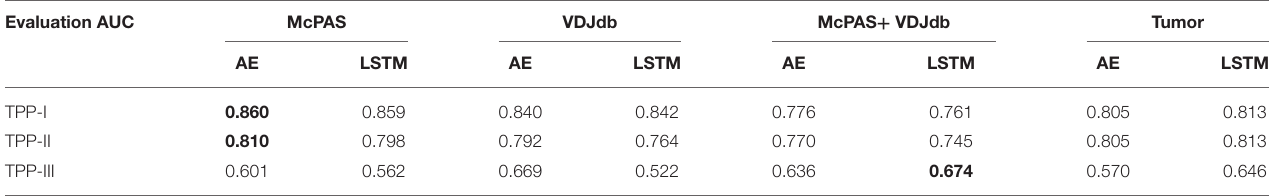
TABLE 4 | AUC of TPP task with either known peptide and TCR (but unknown pairing TPP-I), known peptide unseen TCR (TPP-II), and unseen peptide and TCR (TPP-III). Evaluation